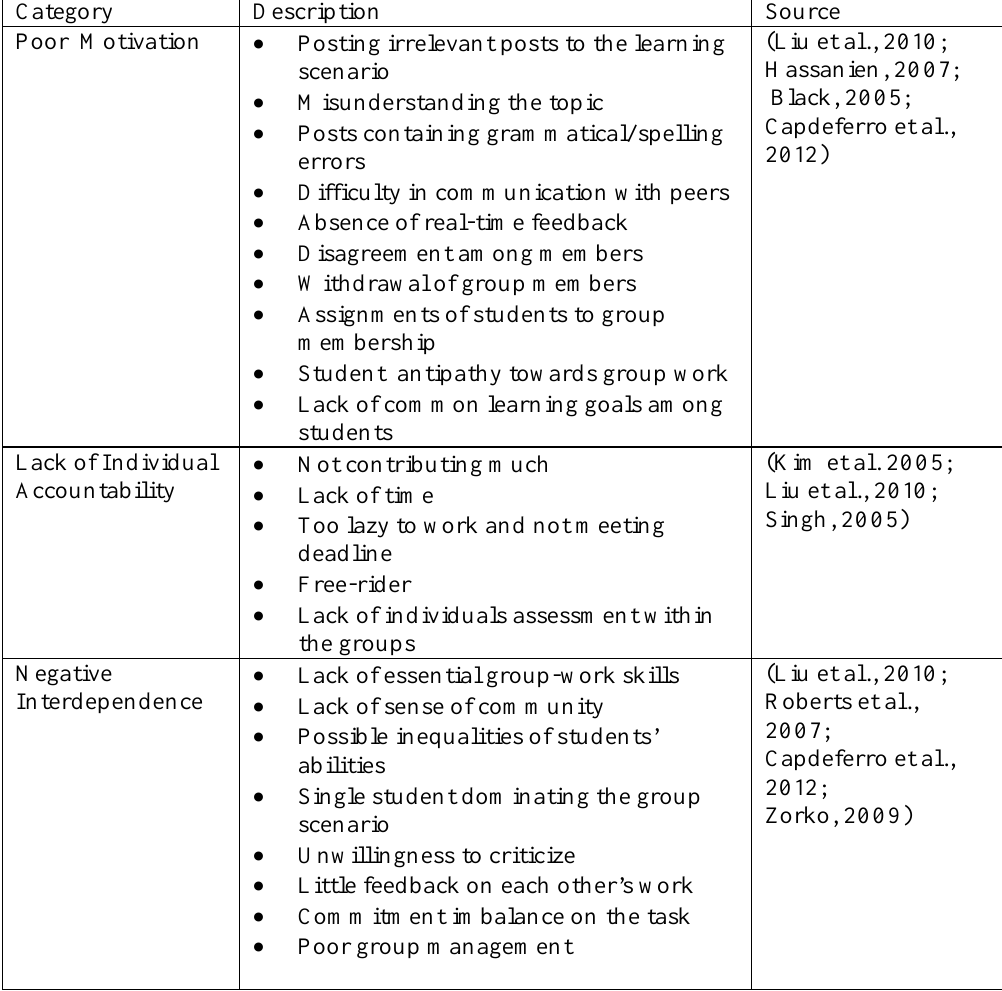
Table 2 Perceived Challenges in Online Collaborative Learning Environment Category Description Source Poor